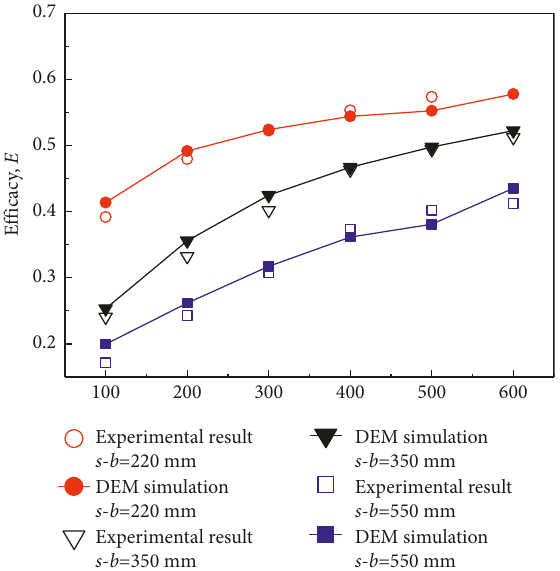
Figure 7: Variation of efficacy with embankment height for various pile-net